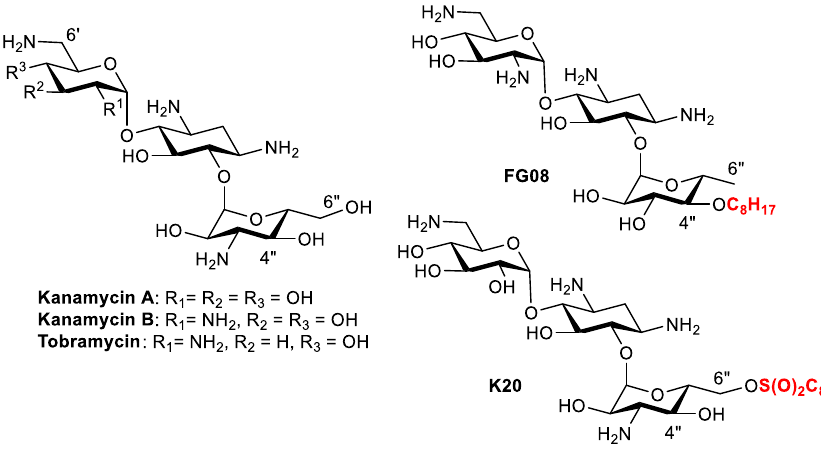
Figure 1. Structure of aminoglycosides and selected kanamycins (AKs).